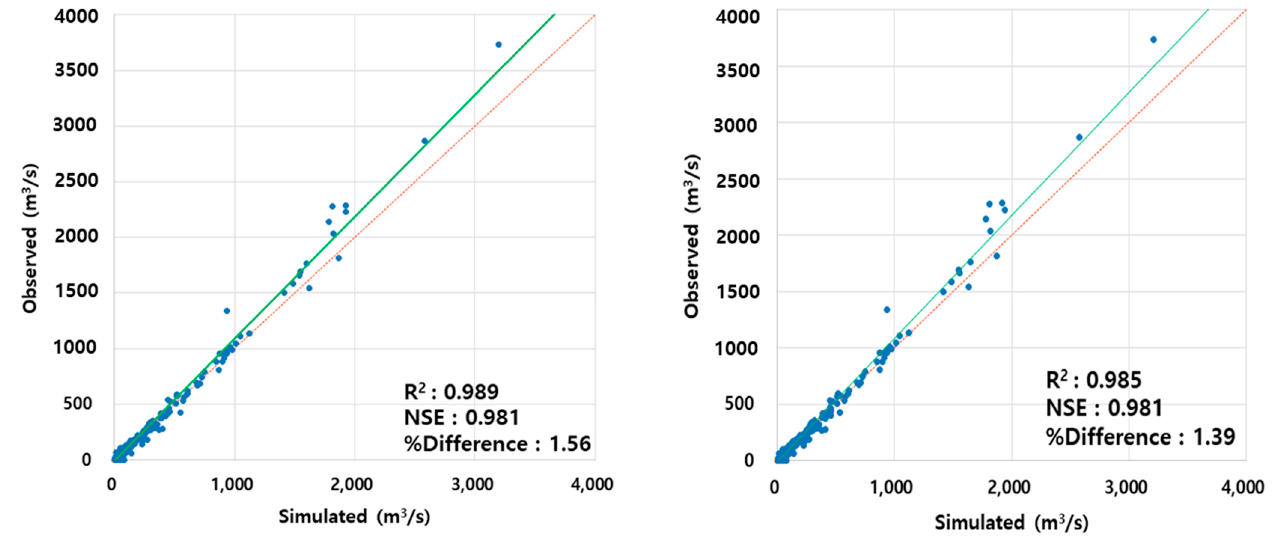
Figure 6. Comparison of simulated and observed flow (calibration period: 2013–2017, simulated value: simulation results of two scenarios, observed value: observed value of Uiam Dam inflow located downstream of the watershed). (( a ) Scenario 1: Simulated vs. Observed Flow; ( b ) Scenario 2: Simulated vs. Observed Flow)